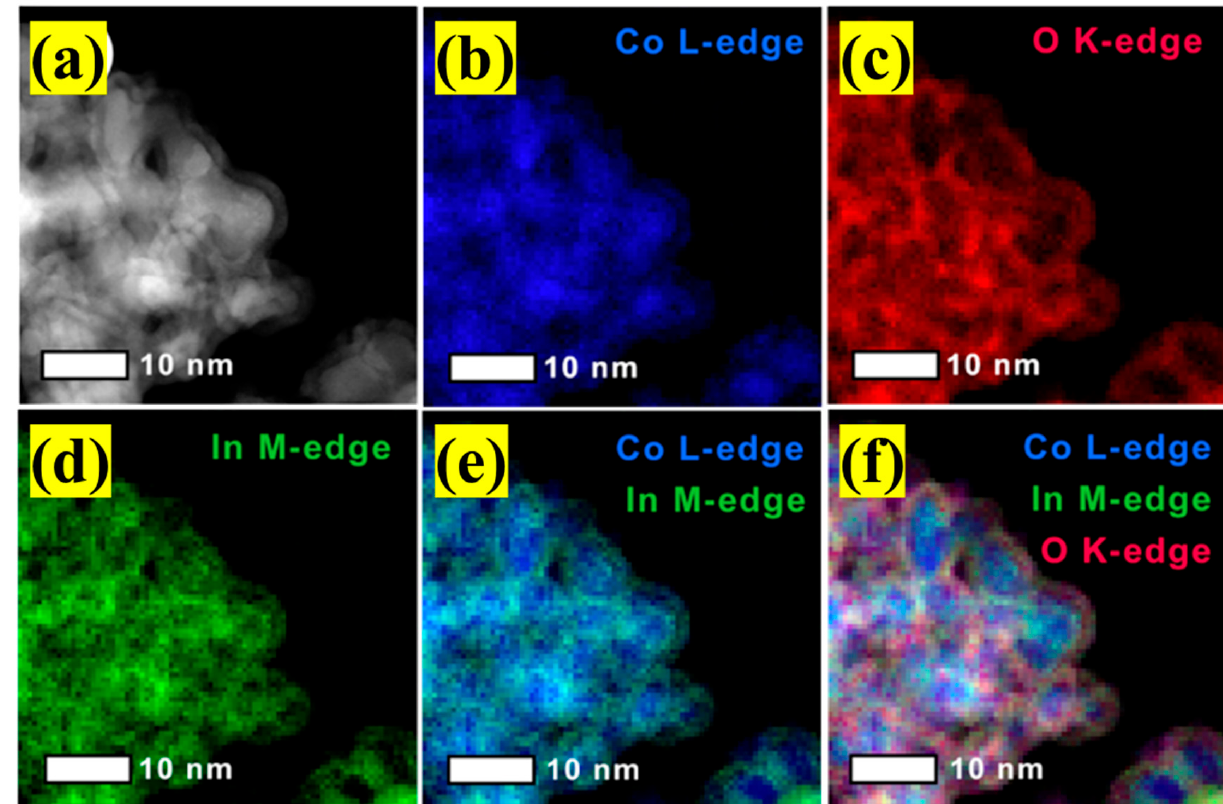
Figure 9. ADF-STEM imaging and elemental mapping for used 3In@8Co(300): ( a ) ADF-STEM image, ( b ) Co map, ( c ) O map, ( d ) In map, ( e ) superimposed Co/In maps, and ( f ) superimposed Co/In/O maps. Reproduced with permission from ref. [80]. Copyright 2020 American Chemical Society.